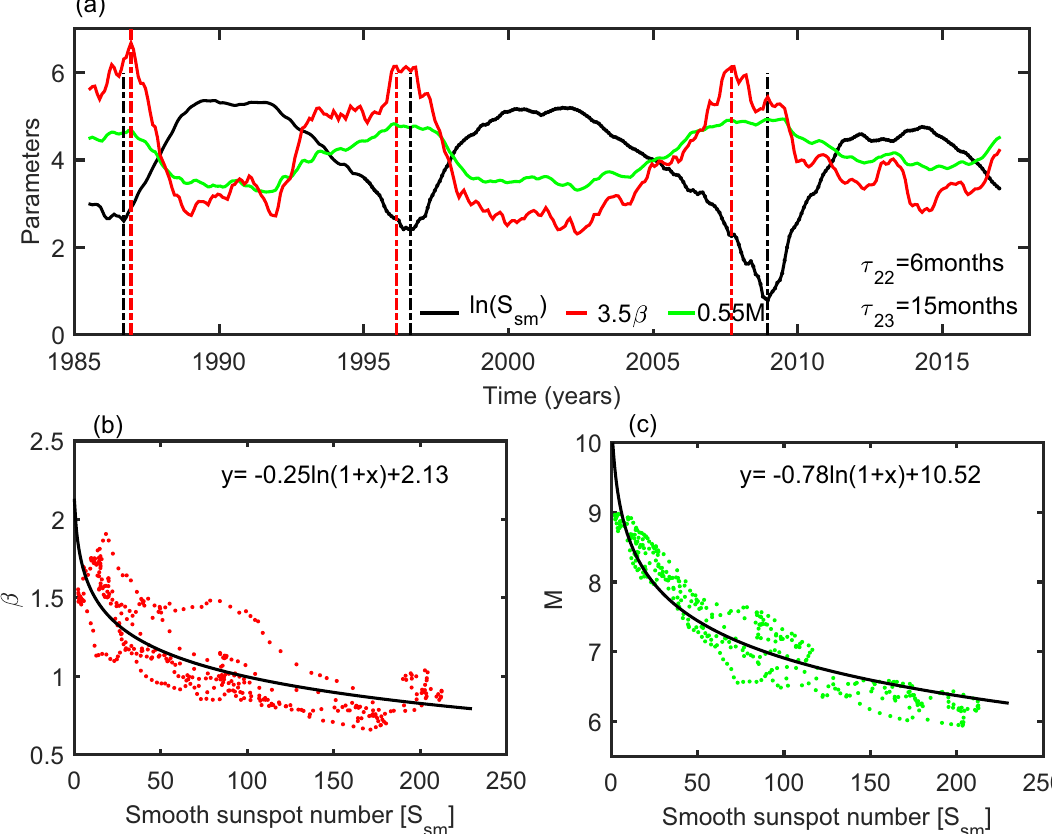
Fig. 5. (a) Comparison of monthly smooth sunspot number (black), SWP beta at the bow-shock nose (red) and solar wind magnetosonic Mach number (green). Maximum in solar plasma beta is seen few months ( s = 5–15 months) before the occurrence of the solar minimum in smooth sunspot numbers. The vertical red (black) dashed lines indicate the peak in SWP beta (minimum in SSN), (b) The solar plasma beta as a function of monthly SSN for SCs 22, 23 and 24. (c) The solar wind magnetosonic Mach number as a function of monthly smooth sunspot number for SCs 22, 23, and 24. The black solid curves indicate the logarithmic fit for these variations and their equations are mentioned in respective